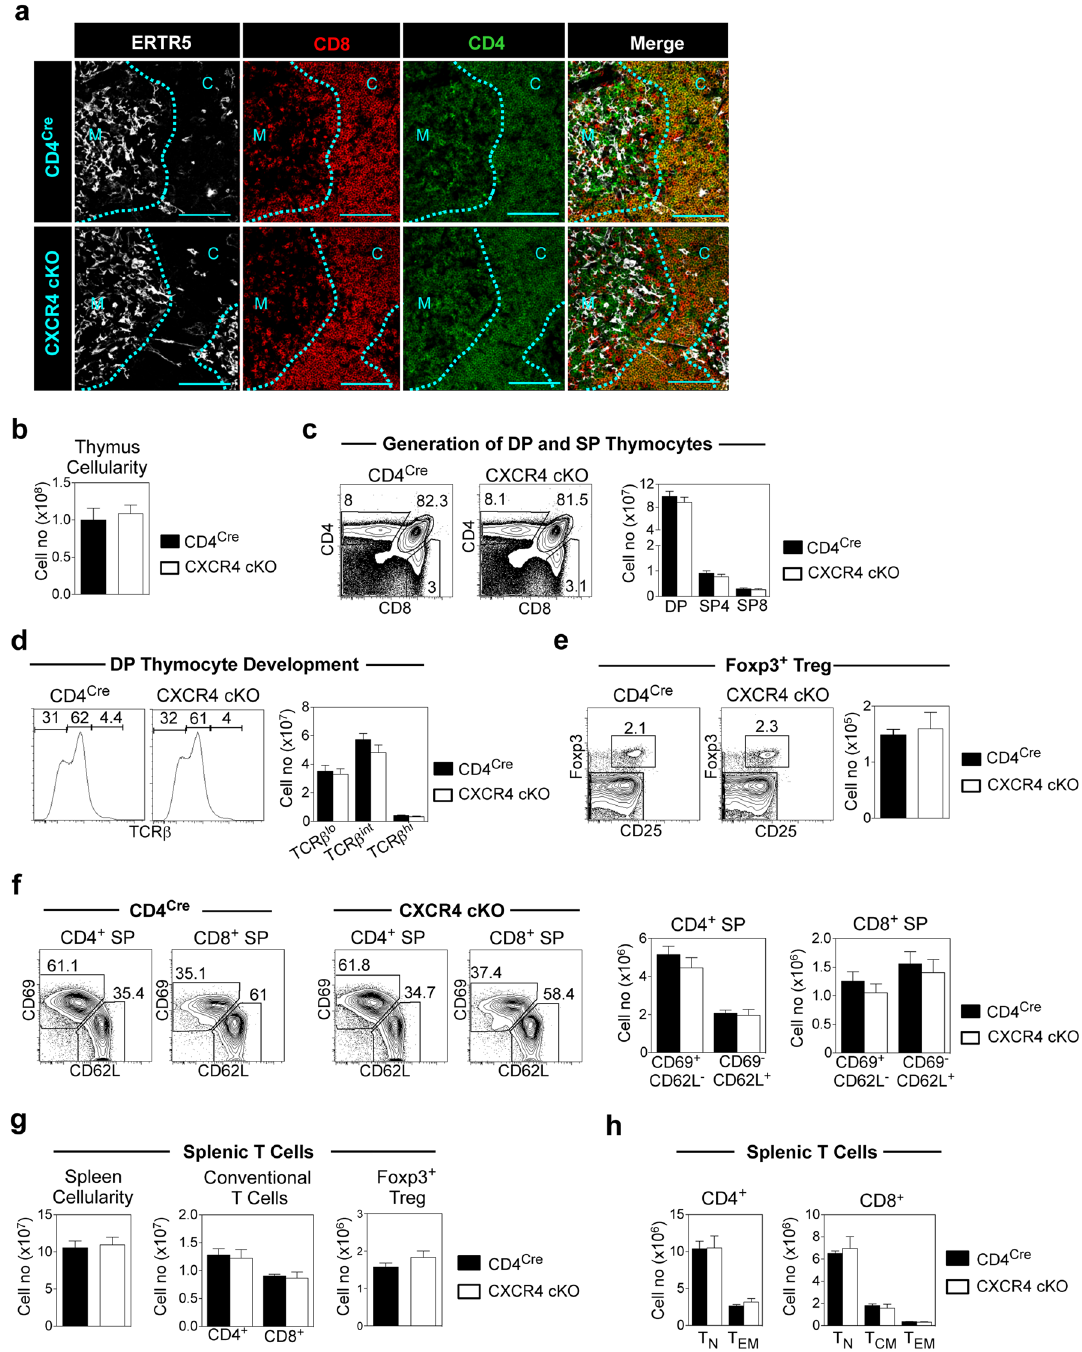
Figure 3. Conventional αβ T-cell Development Occurs Normally In CXCR4 cKO Mice. ( a) Immunofluorescence showing typical positioning of thymocytes in CD4 Cre and CXCR4 cKO mice, ‘C’ denotes cortex and ‘M’ denotes medulla, scale bar represents 100 μ m. ( b) Thymus cellularity of CXCR4 cKO compared to CD4 Cre mice. Representative FACS analysis and quantitation of (c) DP and SP thymocytes, (d) TCR β lo , TCR β int and TCR β hi DP thymocytes, ( e) CD25 + Foxp3 + T-Reg, ( f) CD69 + CD62L − immature and CD69 − CD62L + mature SP4 and SP8 thymocytes from CXCR4 cKO and CD4 Cre control thymus. ( g ) Spleen cellularity and numbers of CD4, CD8 and Foxp3 + T cells in the spleen. ( h ) Numbers of naïve (T N CD62L + CD44 − ), central memory (T CM CD62L + CD44 + ) and effector memory (CD62L − CD44 + ) CD4 + and CD8 + T cell subsets in the spleen of CD4 Cre and CXCR4 cKO mice. All quantitation is generated from at least three independent experiments where n > 7, unpaired Student’s t test shows no significant difference. Error bars represent